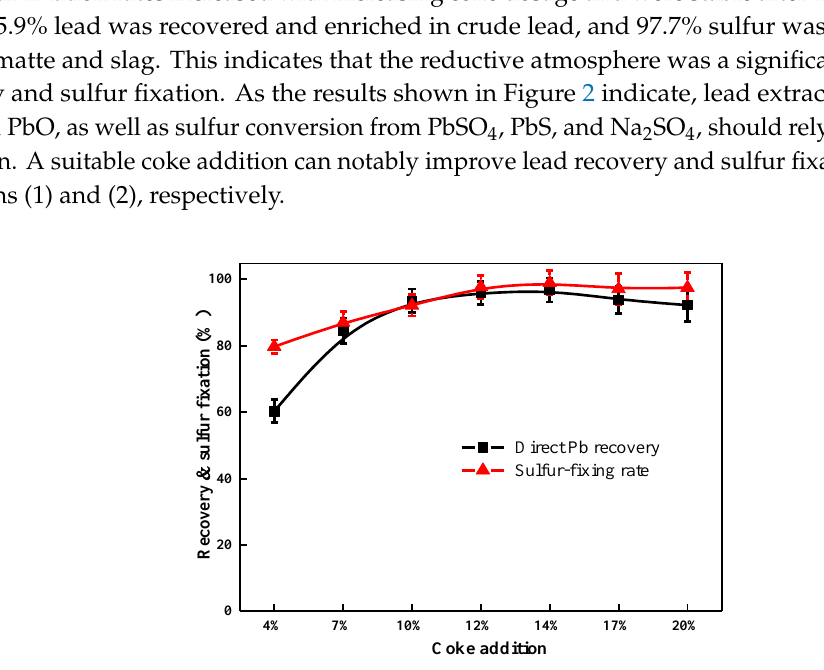
Figure 6. The effects of Na 2 CO 3 dosage on lead recovery and sulfur fixation. (W lead paste :W pyrite cinder :W coke = 200:50:24 g, FeO/SiO 2 = 1.3, CaO/SiO 2 = 0.4, 1200 °C, 2 h).